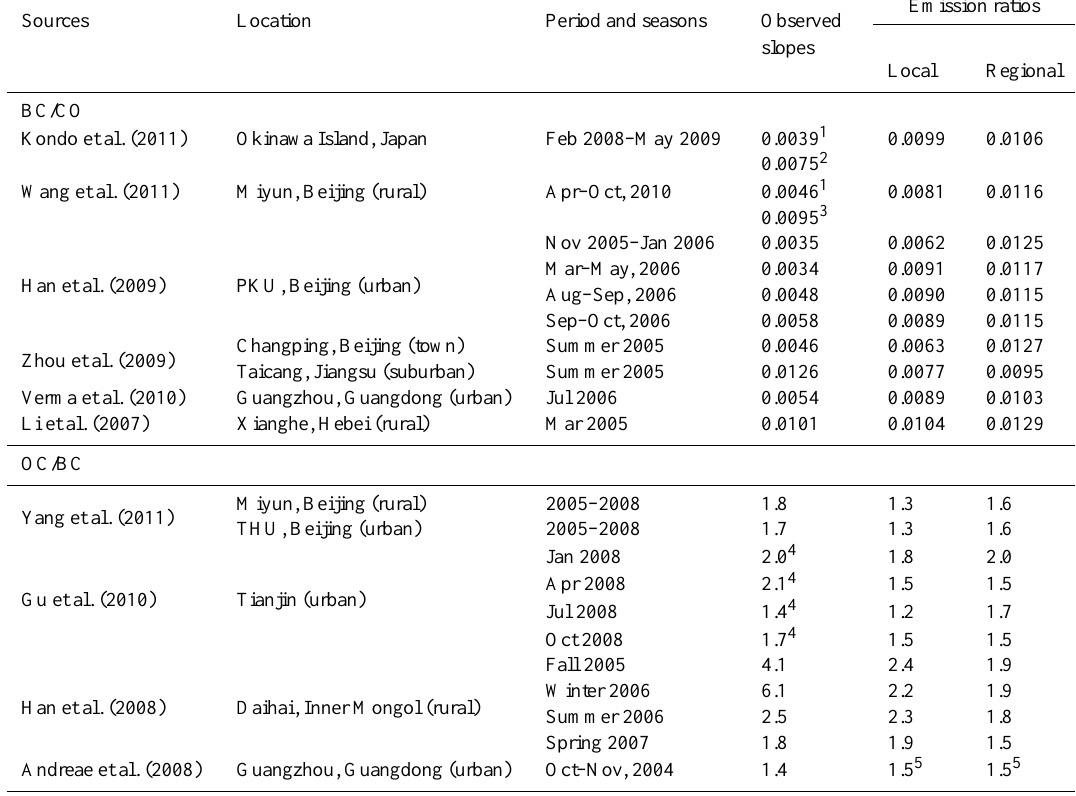
Table 4. The ratios of BC to CO (µgm − 3 ppbv − 1 ) and OC to BC (µgm − 3 /µgm − 3 ) from observations and bottom-up emissions in China.